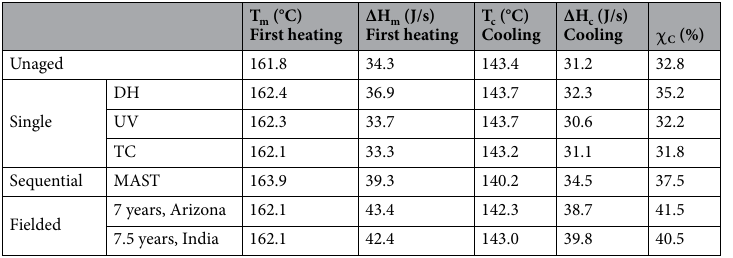
Table 2. Summary of parameters extracted from DSC first heating and cooling cycles for PVDF-B.